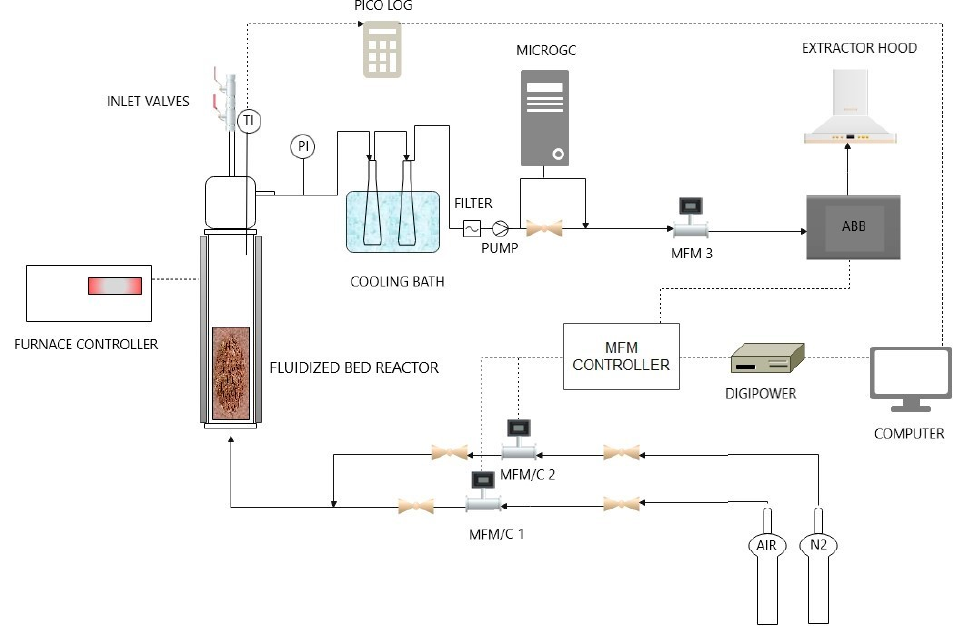
Figure 1. Schematic view of the laboratory-scale experimental apparatus for devolatilization